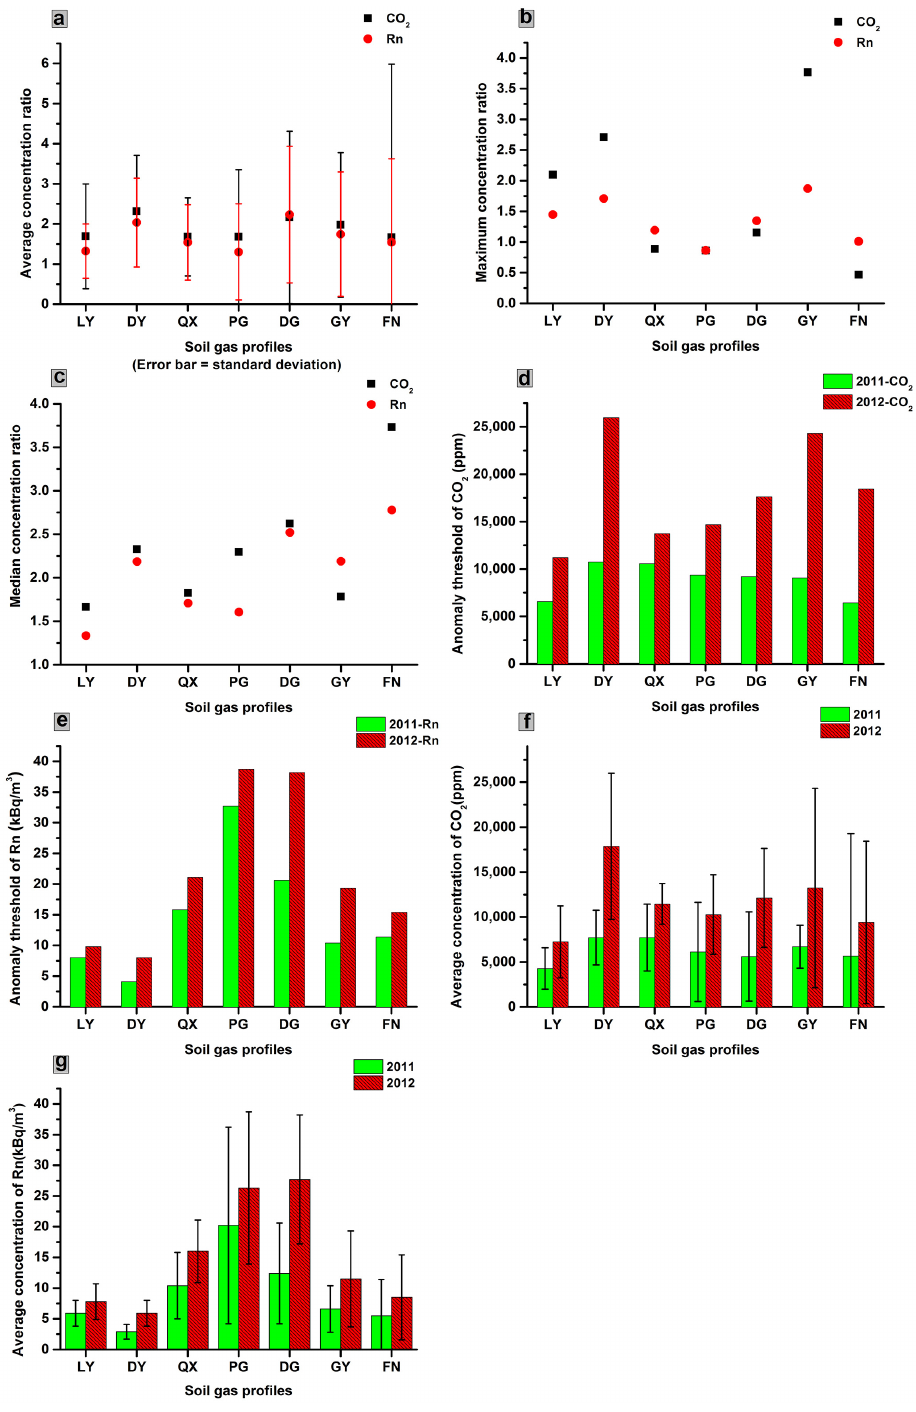
Figure 11. Spatiotemporal variations in soil gases across fault zones in the capital area of China. The profile order used along the x axis was based on the profile number in Fig. 1. (a–c) show the ratios that the average, maximum and median concentrations of soil gases at one profile in the 2012 soil gas survey were divided by that at the corresponding profile in the 2011 soil gas survey, respectively. (d, e) show the anomaly thresholds of Rn and CO 2 at different profiles in the 2011 and 2012 soil gas surveys. (f, g) show the average concentrations of Rn and CO 2 at different profiles in the 2011 and 2012 soil gas surveys. Error bars represent ± 1 standard